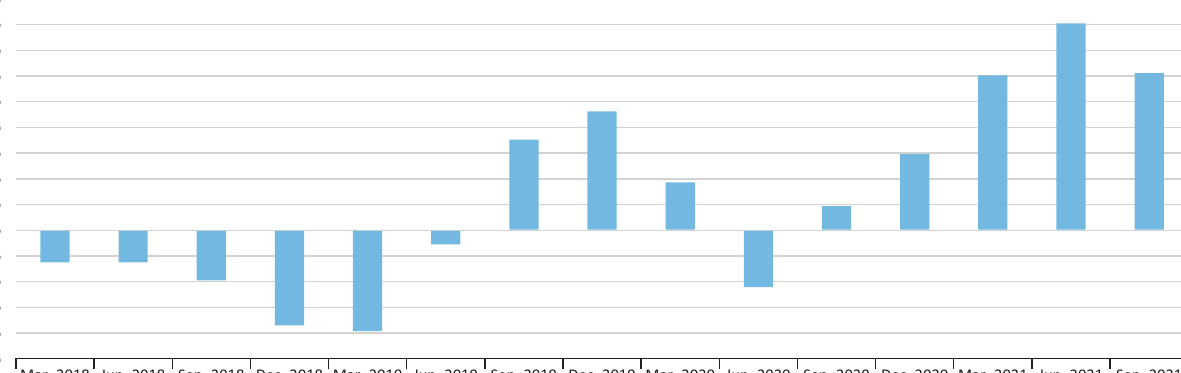
Figure 8. Residential property price index in Sydney from March 2018 to March 2021. Source: Property Council of Australia